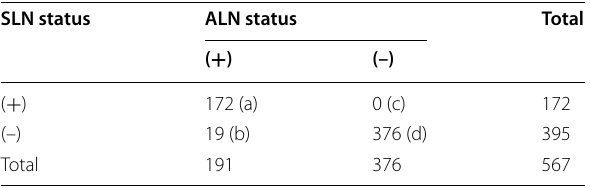
Table 2 ALN metastasis state of 567 patients detected by SLNB